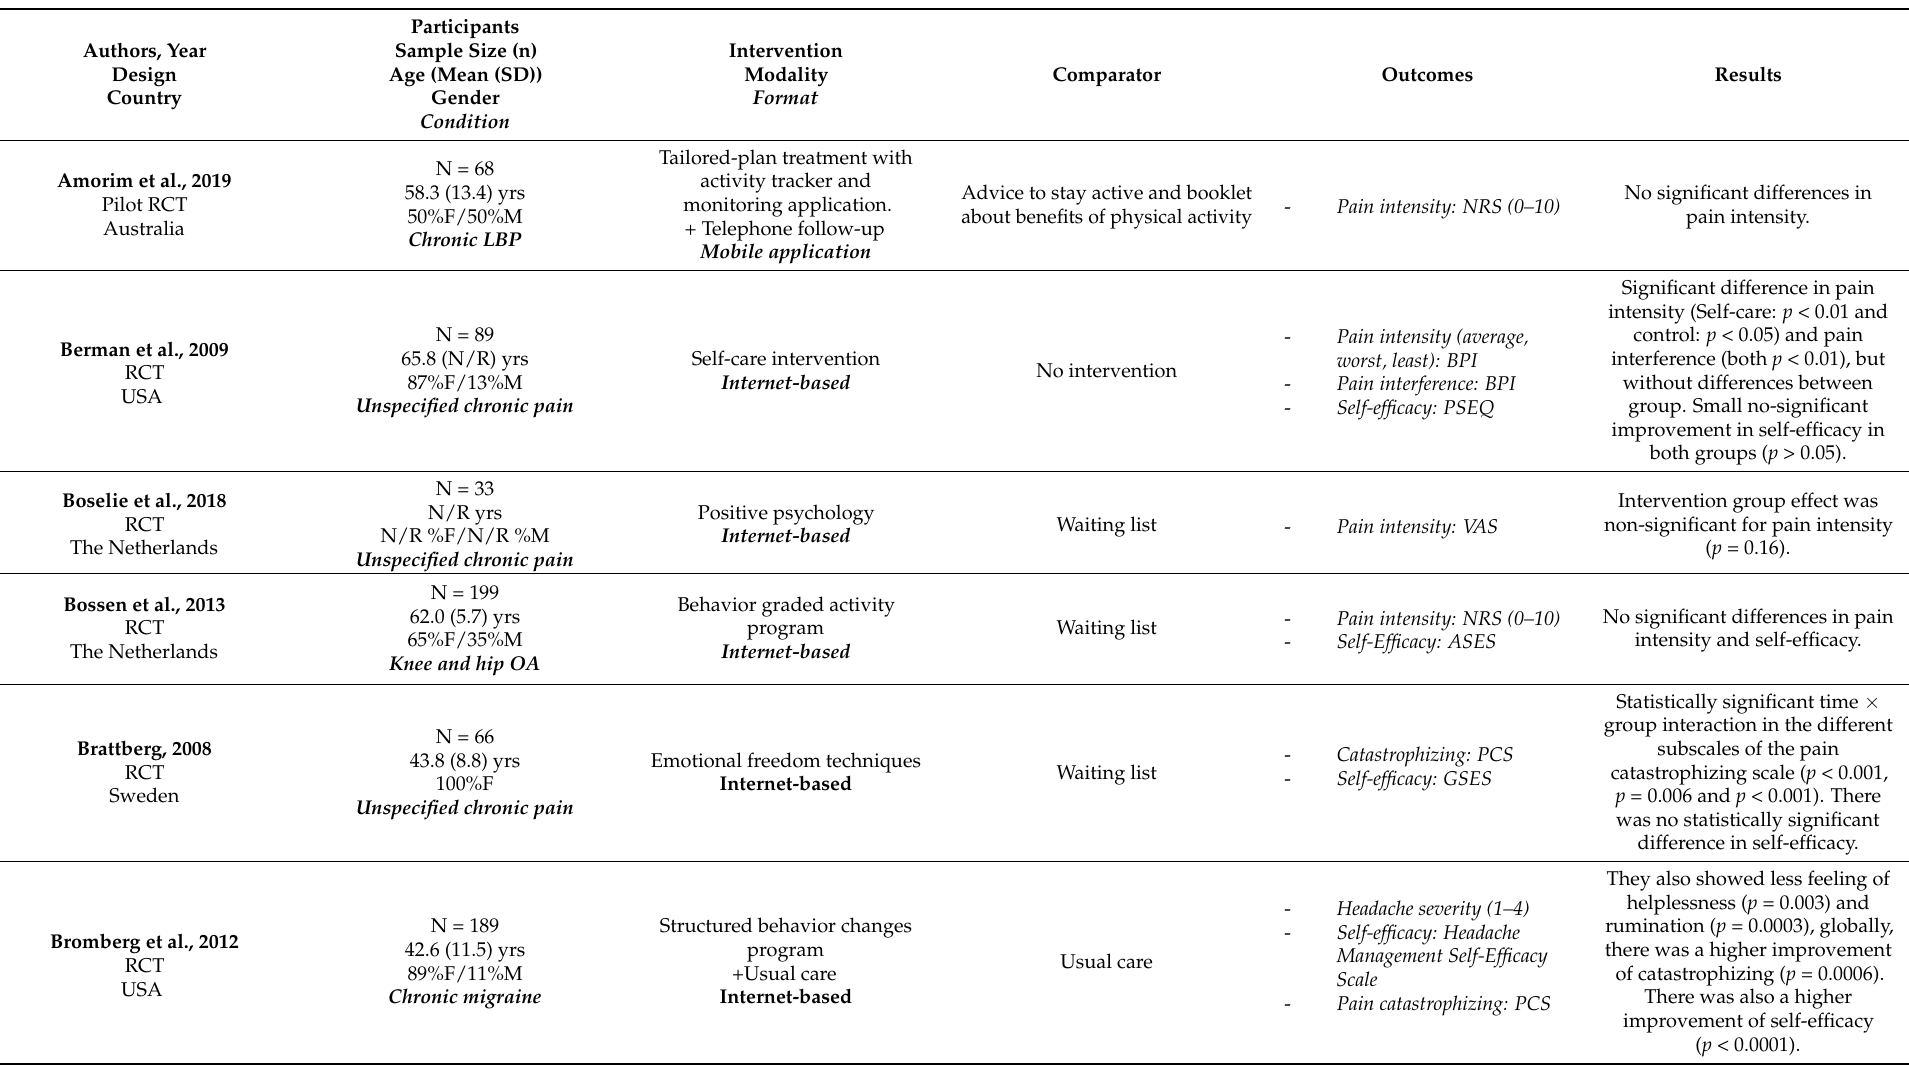
Table 1. Details of the studies included in the systematic